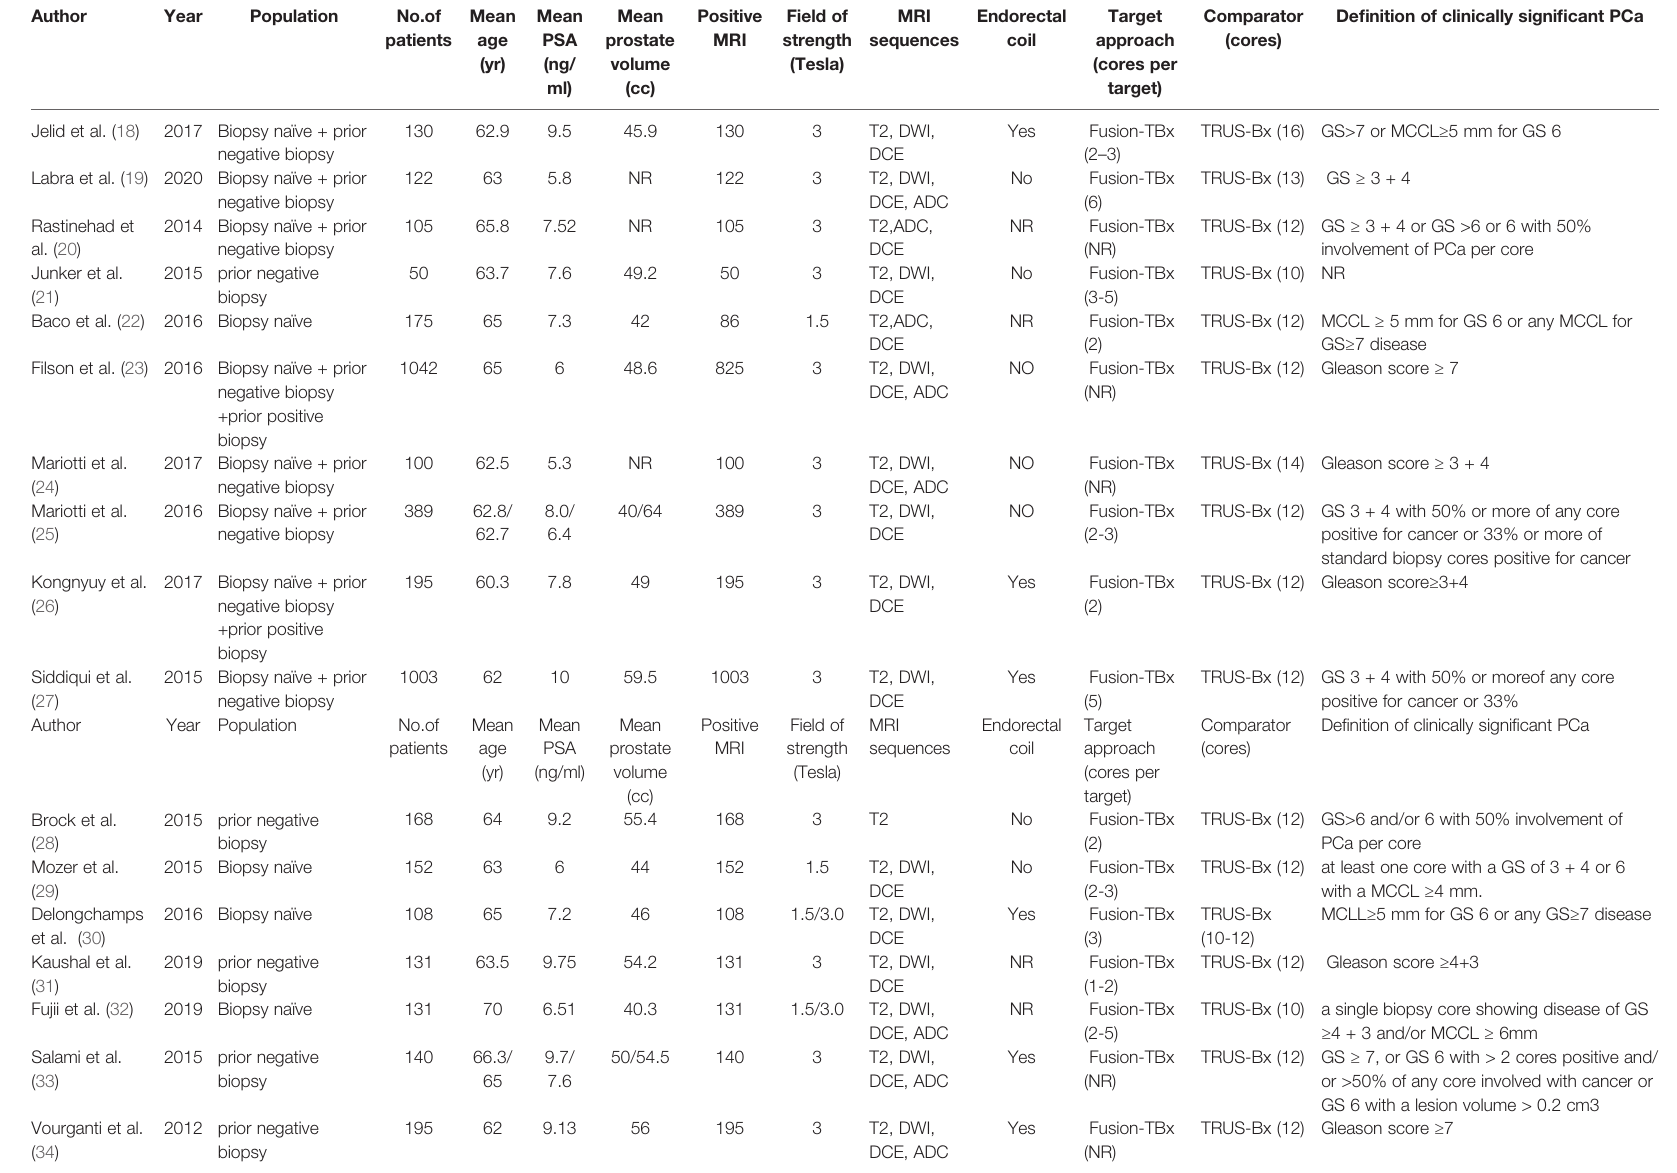
TABLE 1 | Clinical characteristics of include